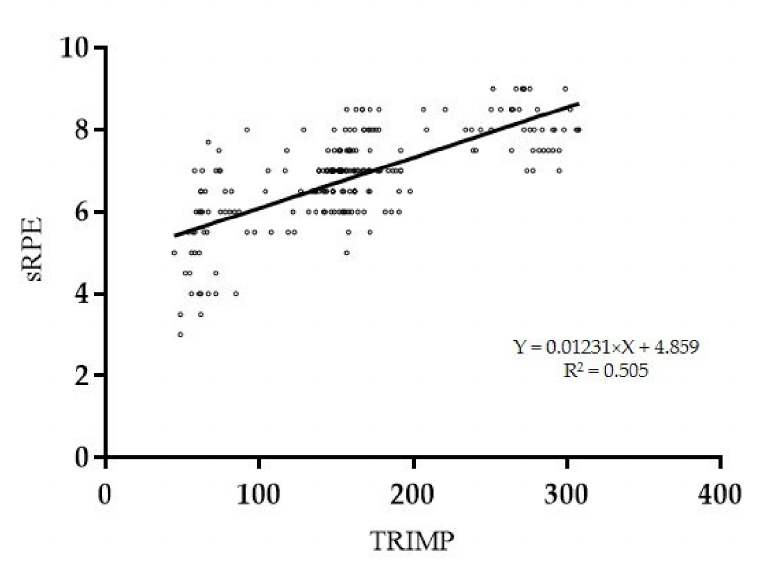
Figure 2. Linear regression between TRIMP (AU) and sRPE